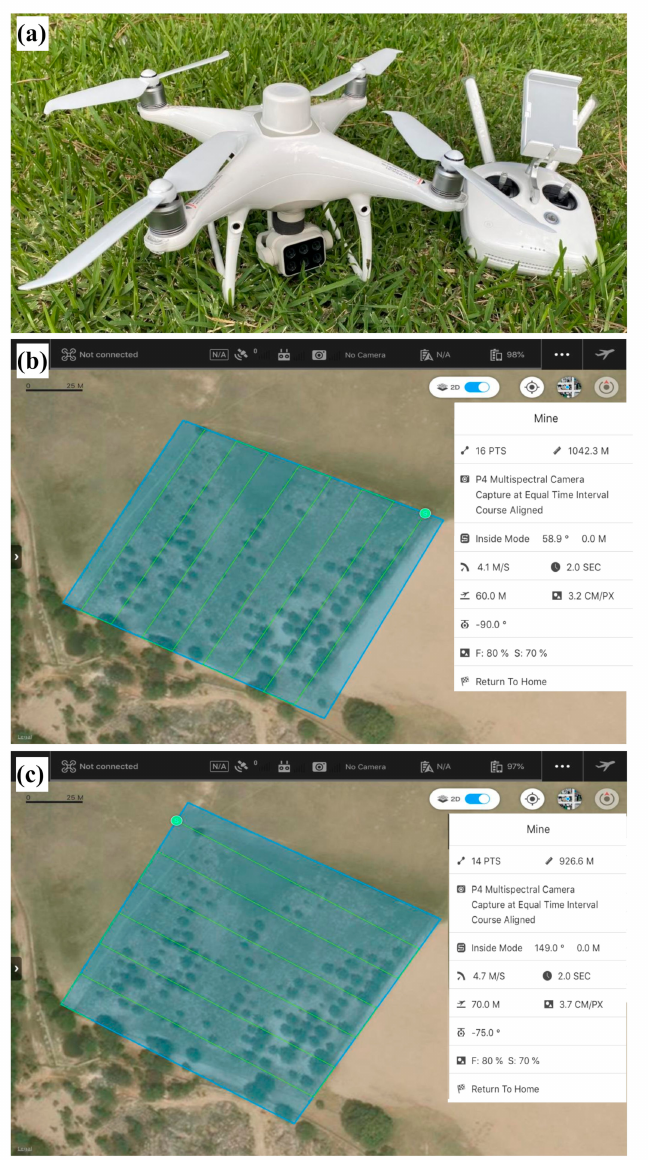
Figure 3. ( a ) DJI Phantom 4 Multispectral UAV used for image acquisition; ( b ) first and ( c ) second grid of flight planning, both made using DJI Ground Station Pro application. Table 1. Spectral-band information for D à -Ji¯ang Innovations (DJI) Phantom 4 Multispectral (P4M). Band Central Wavelength